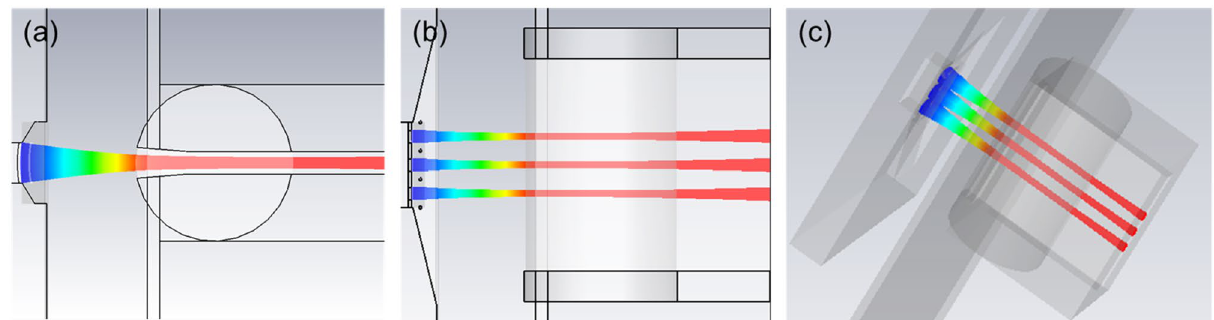
Figure 14. Beam trajectory of the novel planar three-beam gun. ( a ) In the y–O-z plane. ( b ) In the x-O-z plane. ( c ) 3D